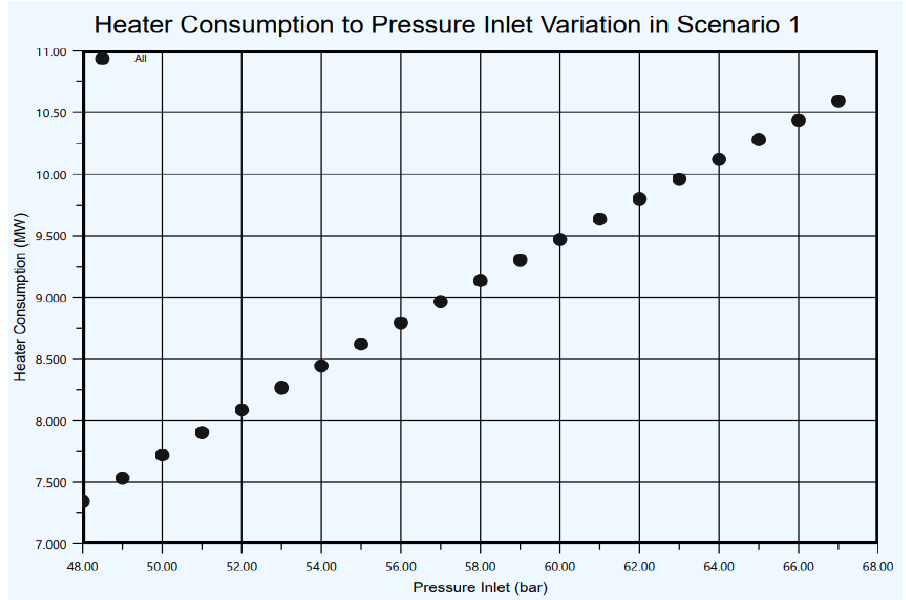
Figure 9. Heater consumption per gas feed pressure